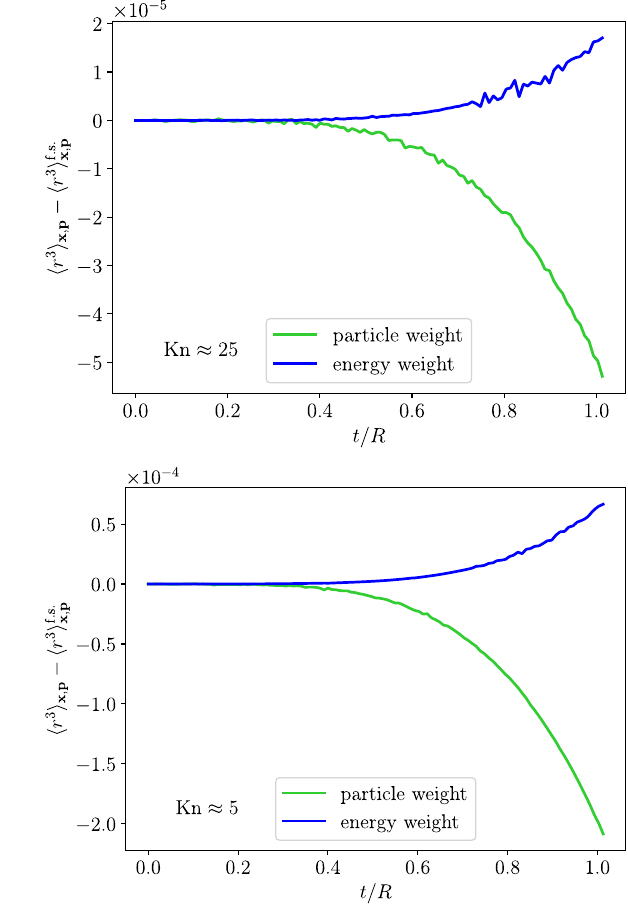
Fig. 15 Time evolution of the departure of −(cid:3) r 3 cos ( 3 θ) (cid:4) x , p with particle-number(green)orenergy(blue)weightingfromitsfreestream- ing value, for simulations with Kn ≈ 25 (top panel) or Kn ≈ 5 (bottom panel)